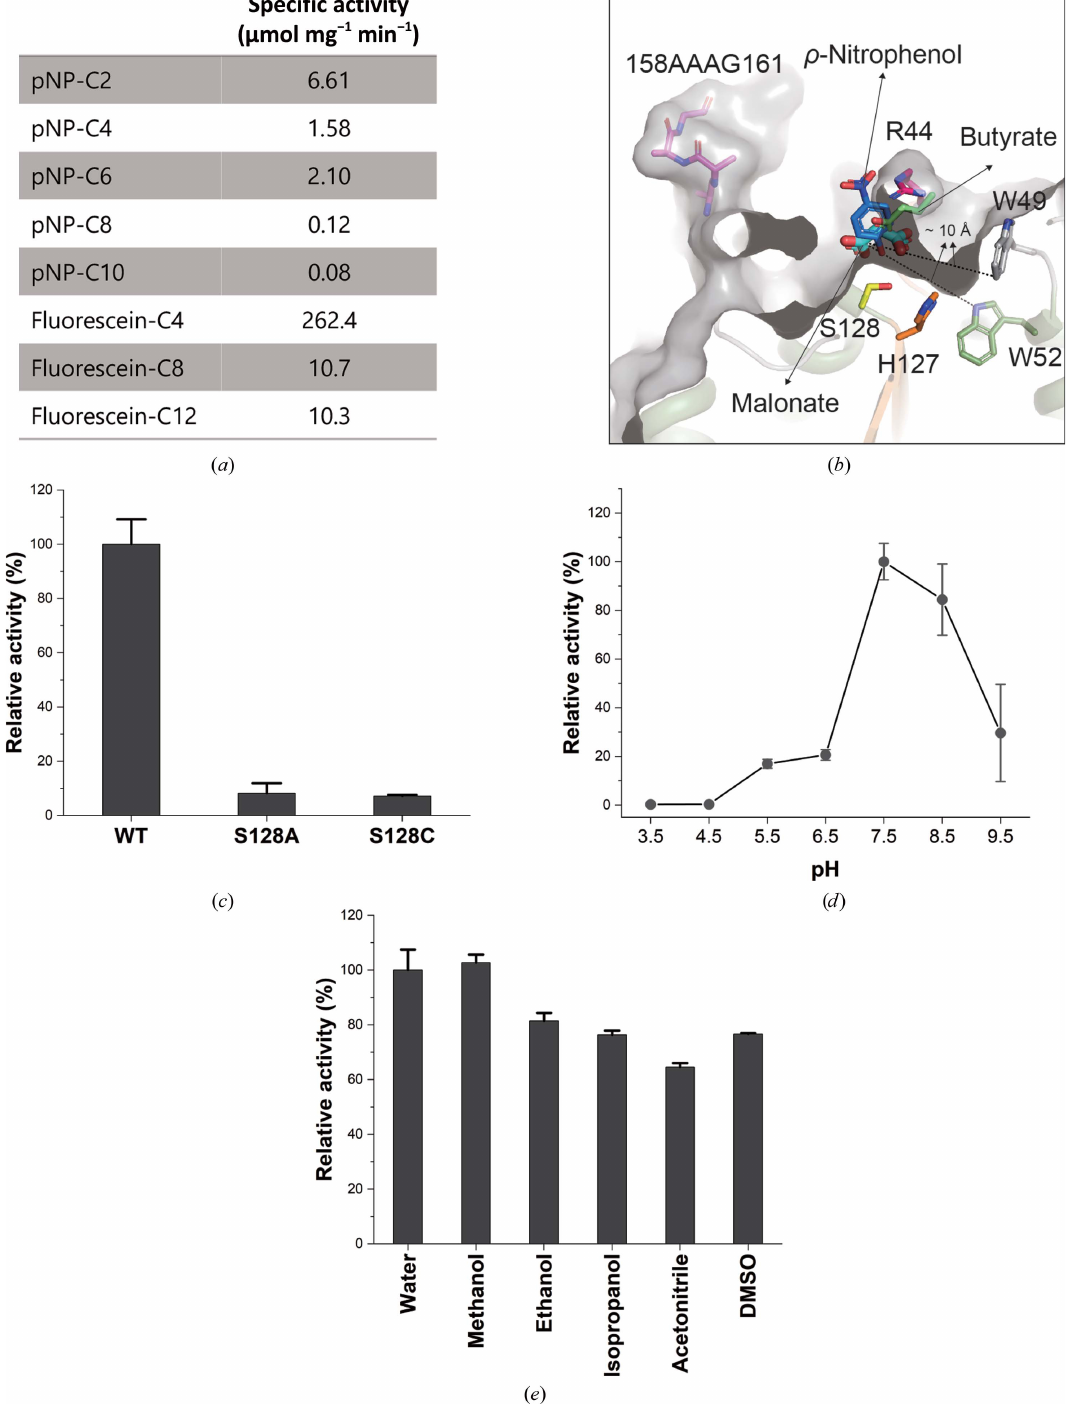
Figure 6 ( a ) Specific activity of PsEst3 against p -nitrophenol ( p NP) esters and fluorescein derivatives. ( b ) Comparison of the ligand-binding mode. The p -nitrophenol-bound structure of Est22 (PDB entry 5hc2) and the butyrate-bound structure of thermophilic esterase (PDB entry 4uhf) are superposed on PsEst3 to compare ligand orientations (Huang et al. , 2016; Sayer et al. , 2015). p -Nitrophenol and butyrate are represented as blue and light green sticks, respectively. Malonate in PsEst3 is shown as relatively thick cyan sticks. The residues that form the binding pocket for an acid are also shown as stick models. The distances between the carbon center of carboxyl group A of malonate and Trp49 and Trp52 are shown as black dotted lines (10.0 and 10.1 A˚ , respectively). ( c ) p NP-C2 hydrolysis activity of PsEst3 Ser128 variants. The effects of varying the pH value ( d ) and organic solvents ( e ) on PsEst3 activity are shown. p NP-C2 was used as the